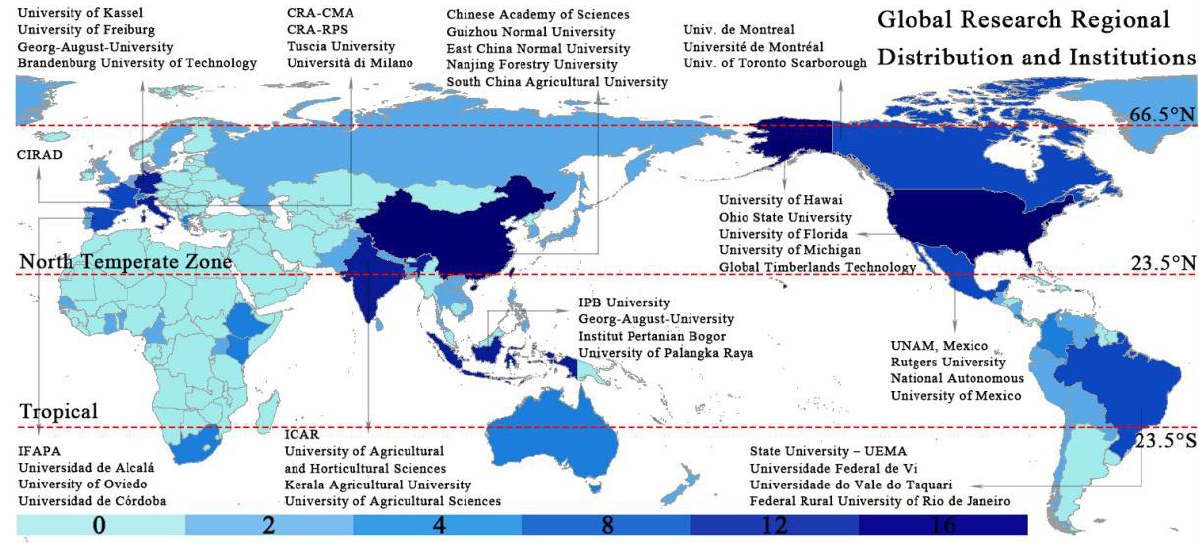
Figure 6. Regional distribution of global literature research and major institutions. The color bands and numbers in the legend indicate the number of publications; the darker the color, the higher the number of articles issued.